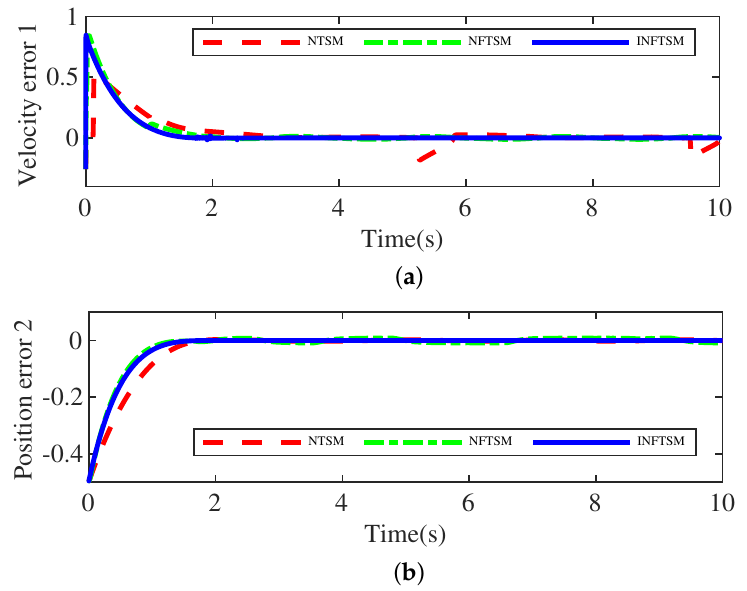
Figure 6. Comparison of velocity error when the system is in fault situation: ( a ) at joint 1 and ( b ) at joint